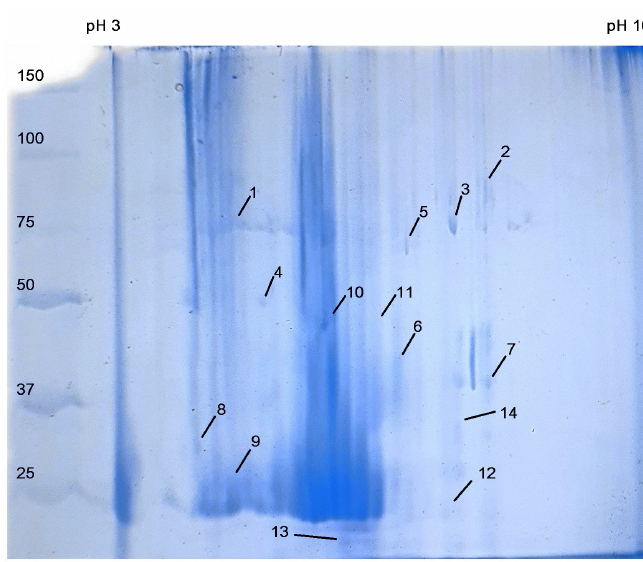
Figure 7. The two-dimensional electrophoresis of potato proteins representative gel. The spot numbers show proteins as listed in Table 2.